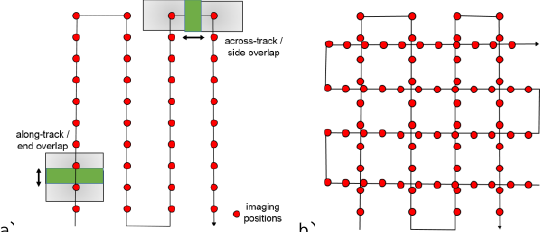
Figure 2. Along-track / end overlap and across-track / side overlap in an UAV flight path composed of parallel